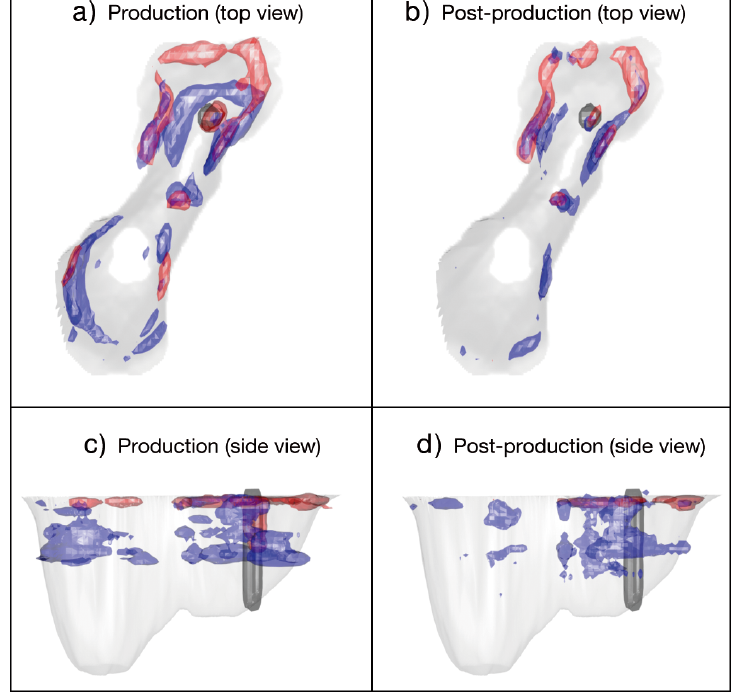
Fig. 3. Core volumetric habitat use (50% 3D kernel utilization distribution [KUD] − all fish) for escaped rainbow trout Onco- rhynchus mykiss (red) and native lake trout Salvelinus namaycush (blue) in Lake 375 (a,c) during commercial production of rainbow trout (Production) and (b,d) after production ceased (Post-production). The near cage habitat (NCH, see ‘Materials and methods’) is represented by the black cylinder